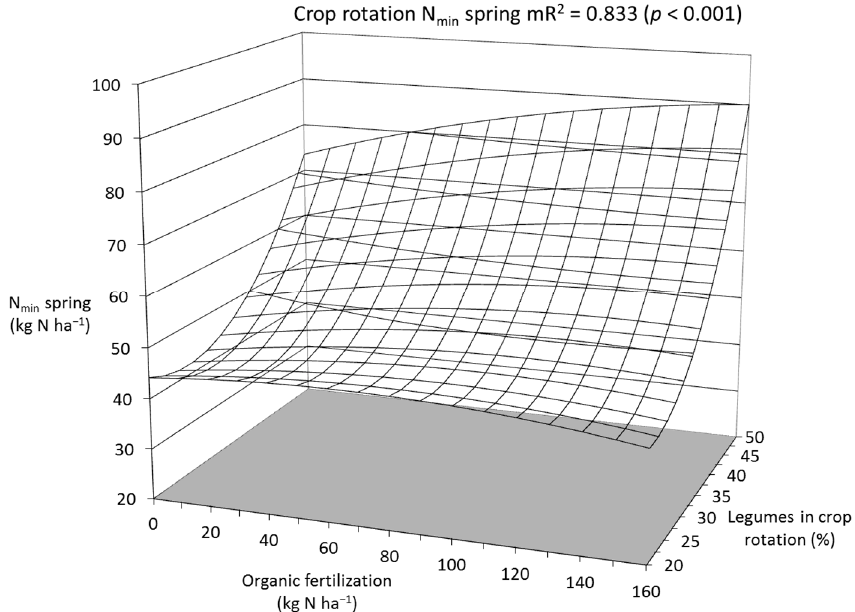
Figure 7. Effects of increasing organic N fertilization and legume proportions in crop rotations on soil N min contents in early spring on heavy soils.